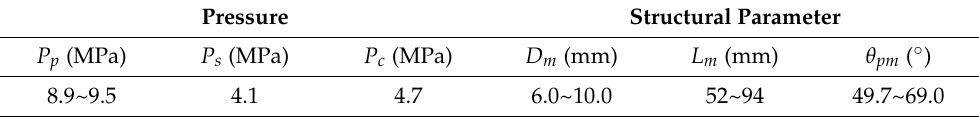
Table 4. Size changes for